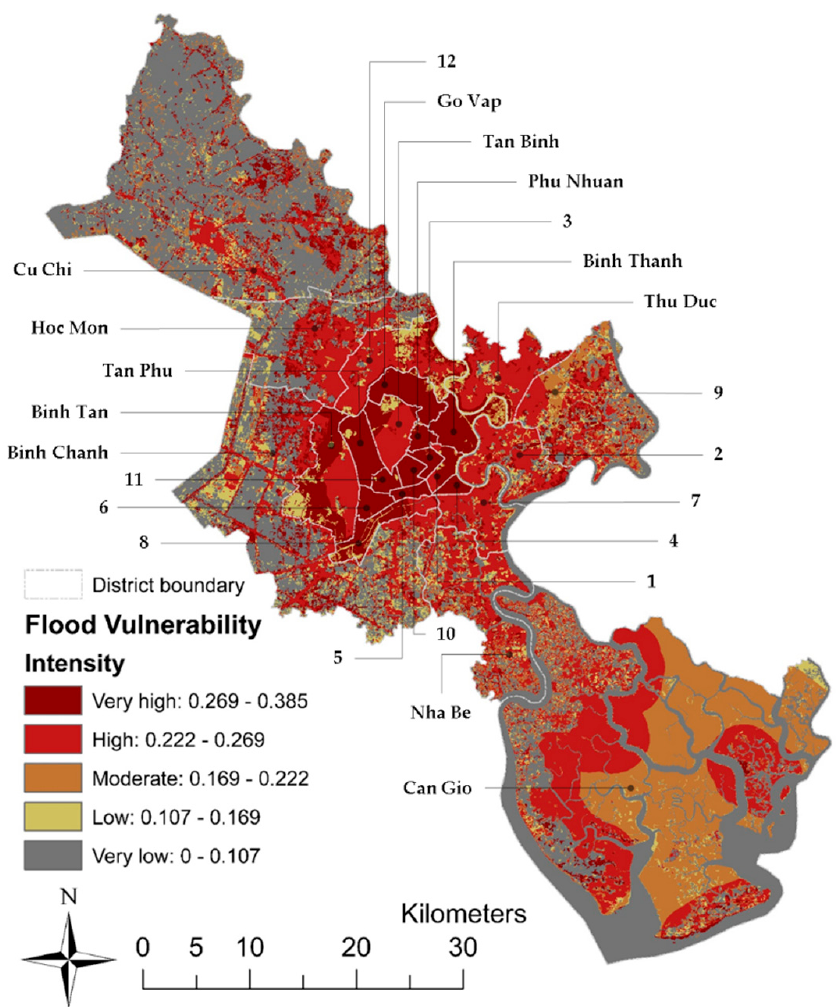
Figure 4. The spatial distribution of flood vulnerability in HCMC.